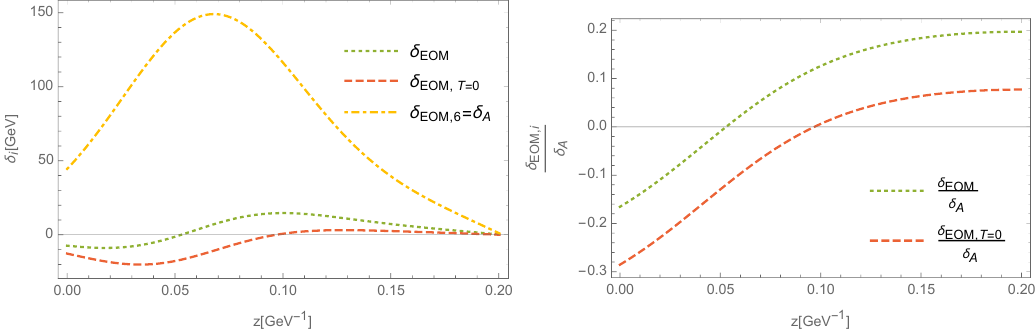
Figure 4 . Left panel: (cid:14) EOM (green, dotted) and (cid:14) EOM ; 6 = (cid:14) A (yellow, dotted-dashed) as a function of z in the broken phase. The di(cid:11)erence arises from the terms proportional to (cid:20)T 2 (cid:30) 3 eq. (5.3). To see the relative relevance of these two terms, we also plotted (cid:14) EOM ;T =0 (red, dashed), where the thermal corrections are neglected. Right panel: (cid:14) EOM =(cid:14) A in the broken phase. In dotted green the (cid:12)nite temperature corrections are included, in dashed red they are